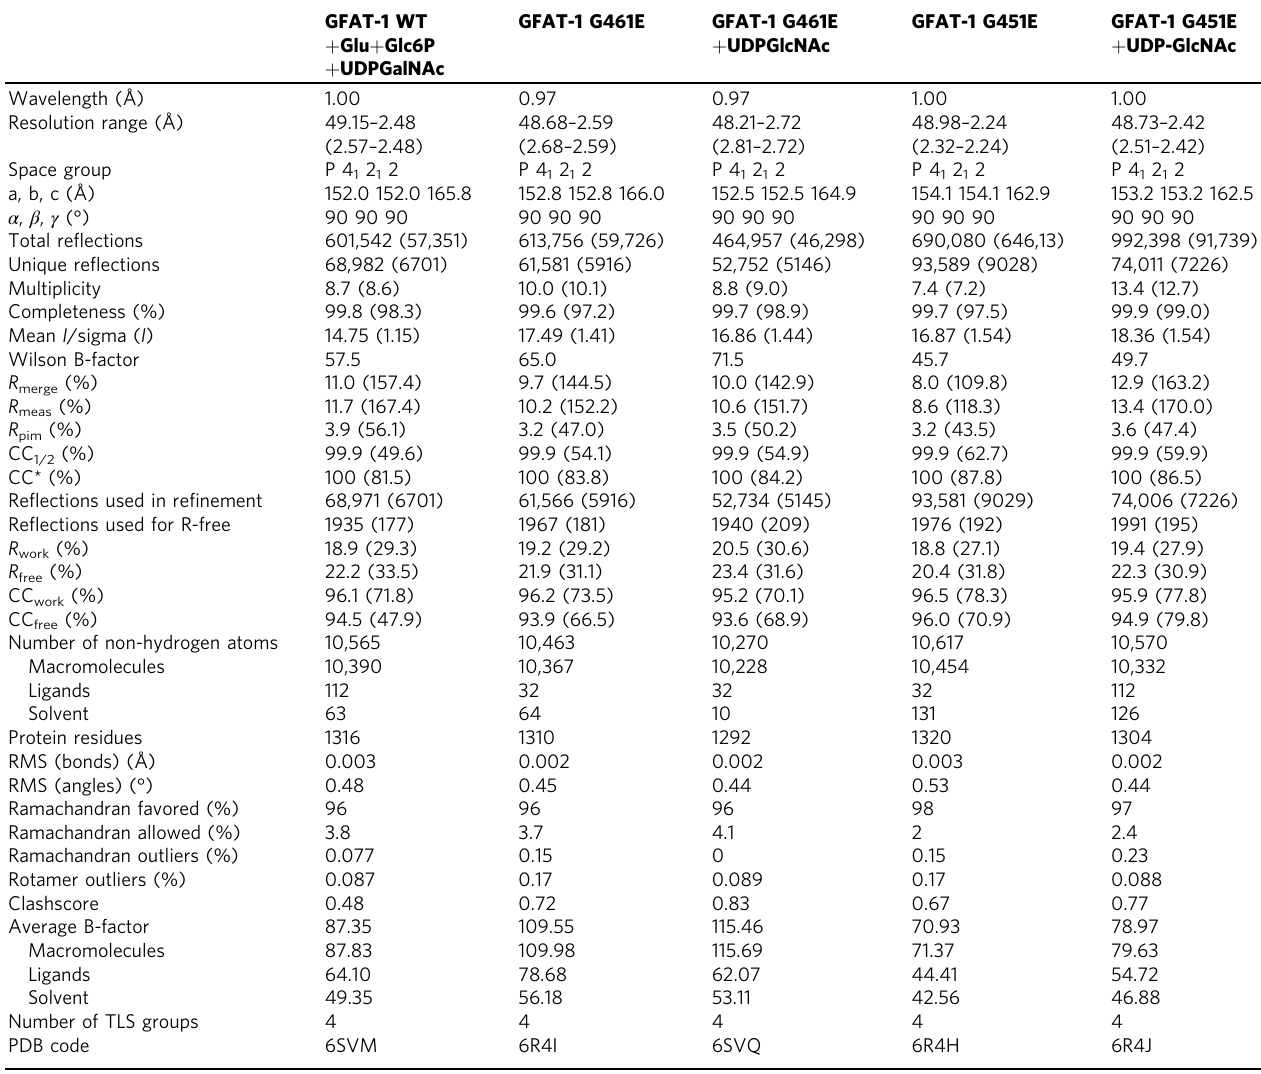
Statistics for the highest-resolution shell are shown in